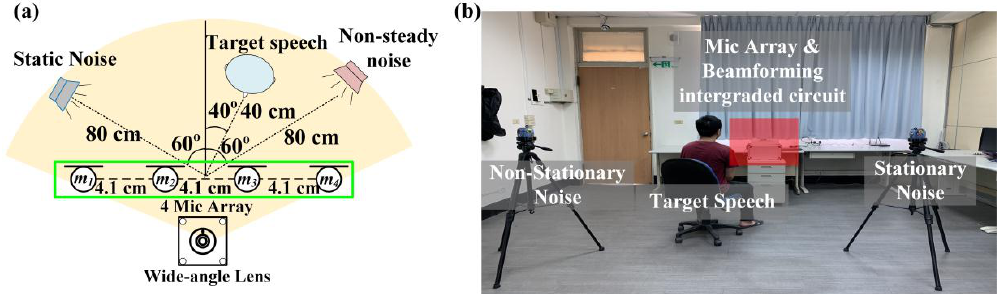
Figure 8. ( a ) Simulation experiment environment schematics; ( b ) Configuration scenarios of non-stationary noise and target sound source.